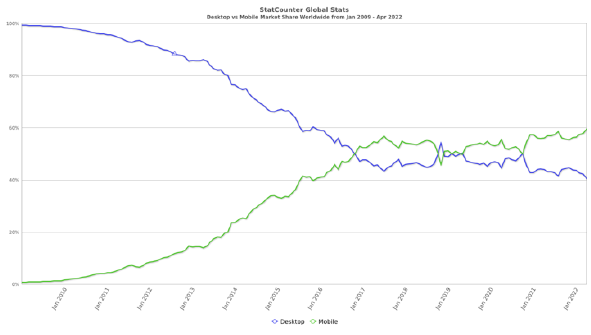
Figure 3. Global market share ( 16 ): desktop (blue line) and mobile devices (green line) from Jan 2009 to April